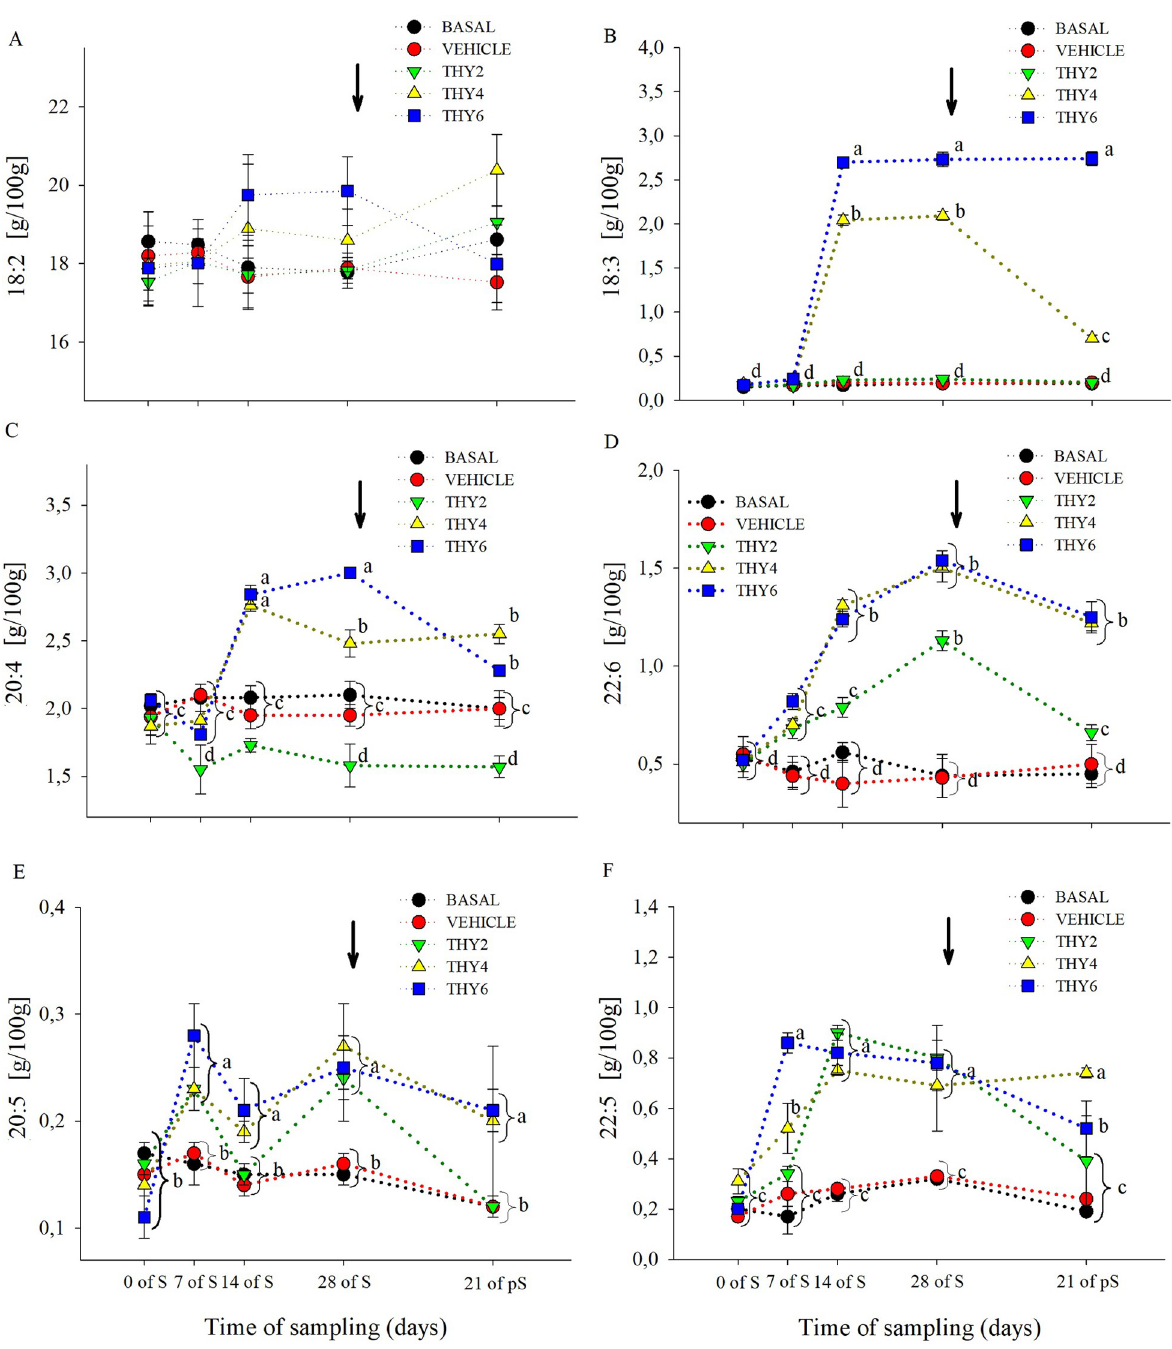
Fig 6. Concentration polyunsaturated fatty acids of quail egg yolk. Mean ± SEM of content (g/100 g FAME) of (A) linoleic (18:2), (B) linolenic (18:3), (C) arachidonic (20:4), (D) docosahexaenoic (22:6), (E) eicosapentaenoic (20:5) and (F) docosapentaenoic (22:5) acids of quail egg yolk laid by females fed on the control diets (BASAL and VEHICLE) or supplemented with 2, 4, and 6.25 g of thymol/kg of feed (THY2, THY4 and THY6, respectively) at 0, 7, 14, and 28 days of the supplementation period (S) and after 21 days of supplement withdrawal (pS). Arrow pointing down indicates the end of the S period. Different letters (a, b) indicate statistical differences. Brackets refer to measurements within a time of sampling. The same 25 females (5 per diet supplied) were analyzed on each of the five sample points (125 eggs total).